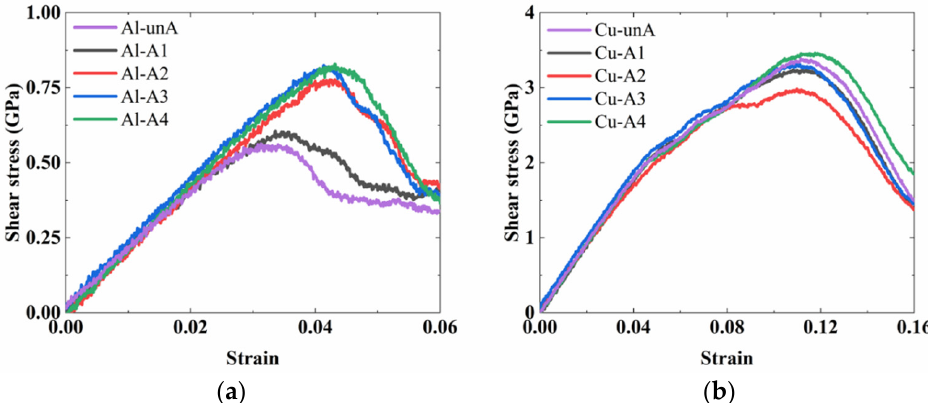
Figure 16. The shear stress–strain curves of the interfacial structures before annealing and at differ ‐ ent temperatures of annealing of ( a ) Al 2 Cu–Al structures and ( b ) the Cu–Al 4 Cu 9 structures.